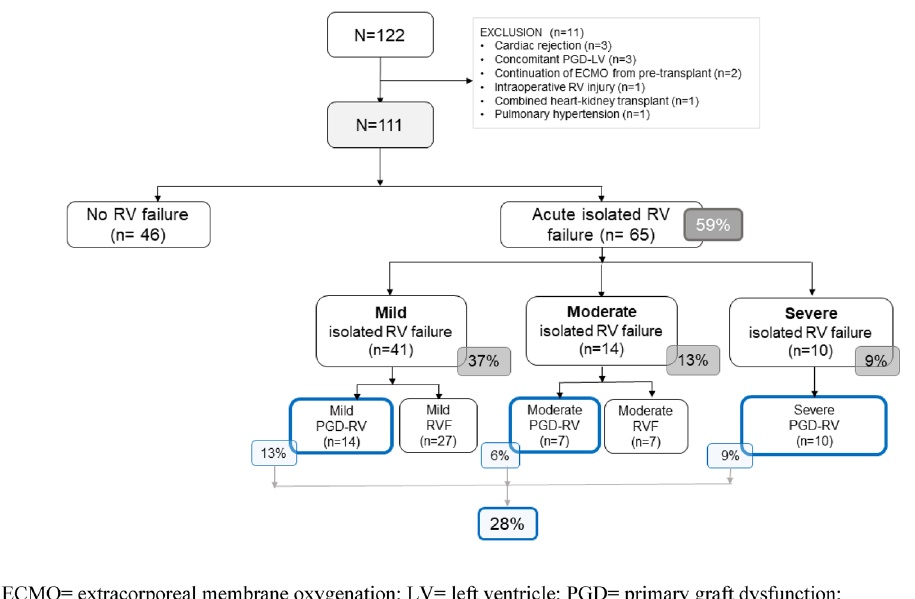
Figure 1. Categories and subcategories of study